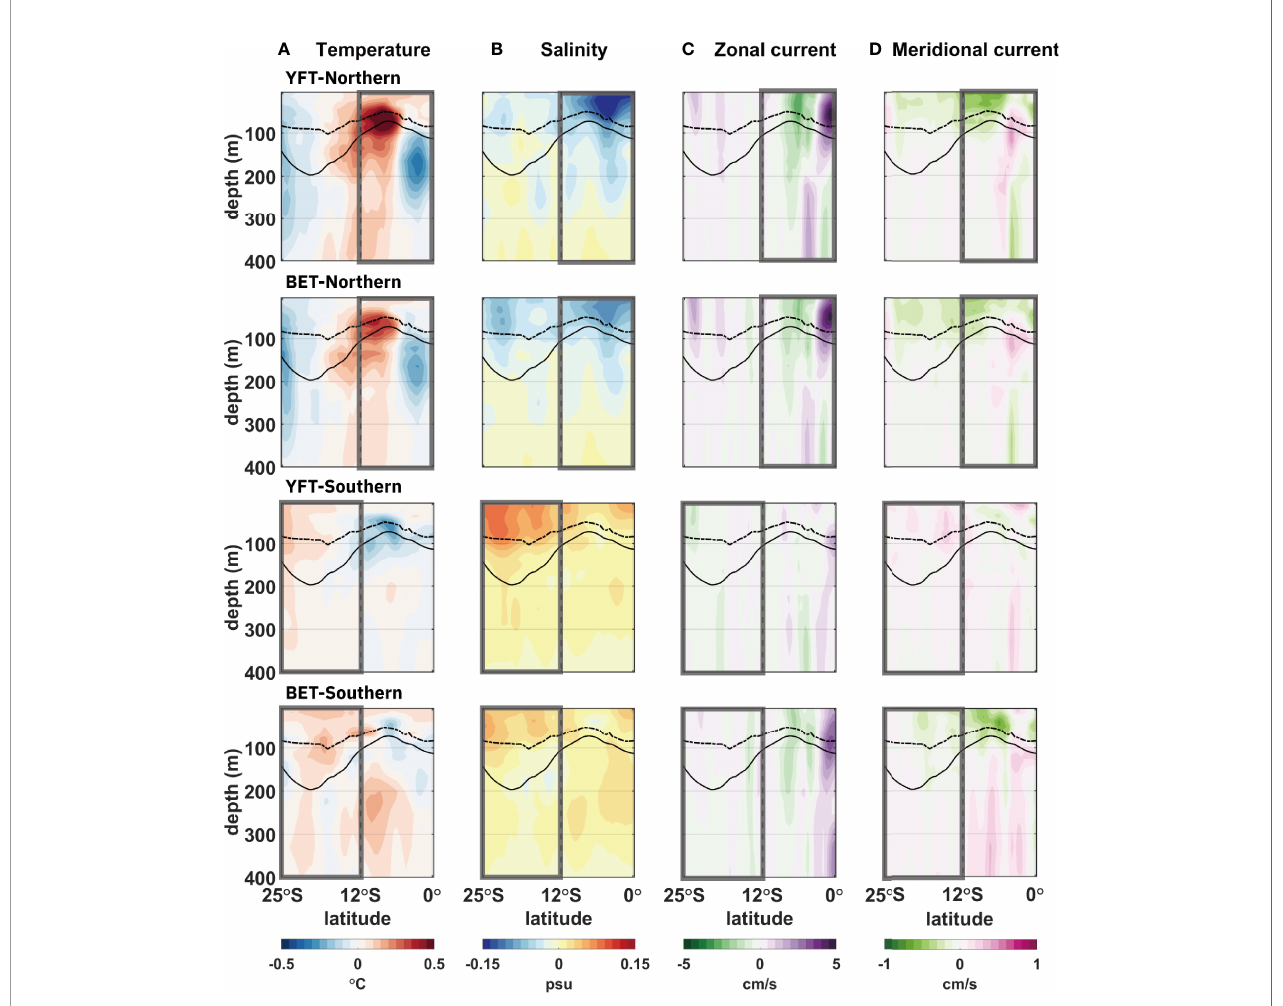
FIGURE 4 | Meridional distributions of the regressed and reconstructed anomalies of the ocean environmental variables during 1990 – 2014. Target time series are the annual catch amounts of yellow fi n tuna (YFT) and bigeye tuna (BET) in the northern (top two rows) and southern (bottom two rows) regions; the target time series are referred as YFT-Northern, BET-Northern, YFT-Southern, and BET-Southern, respectively. The anomalies are presented after zonal averages from 54°E to 60°E. Each column represents a different variable: (A) temperature (shading intervals: 0.05°C), (B) salinity (shading intervals: 0.015 psu), (C) zonal current velocity (shading intervals: 0.5 cm/s), and (D) meridional current velocity (shading intervals: 0.1 cm/s). The thick dashed/dotted lines and solid lines indicate the mean thermocline depth and D20, respectively. The gray boxes indicate the northern or southern region of the SWTIO, denoting the region of each target time